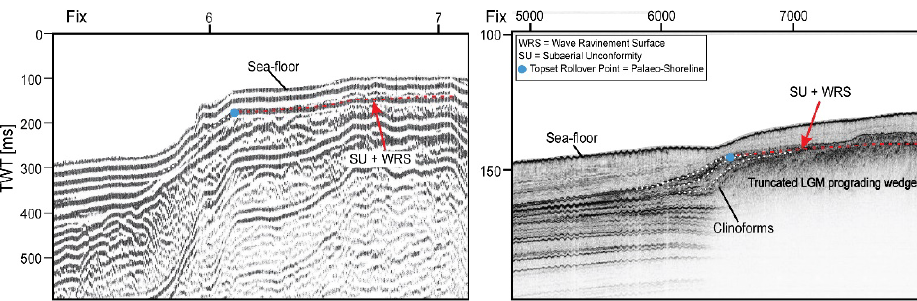
Figure 2. Two representative high-resolution seismic profiles (sparker on the left and chirp on the right) of the Adventure Plateau edges that highlight the morphological and inner geometric charac- teristics of the truncated prograding wedge and erosional surfaces at the LGM sea level minimum.